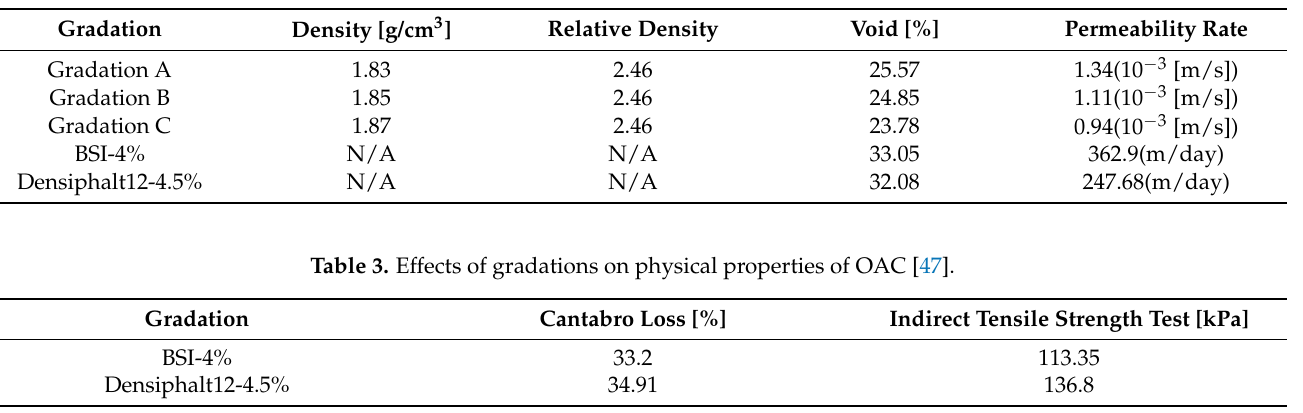
Table 2. Effects of gradations on permeability of OAC [46,47].